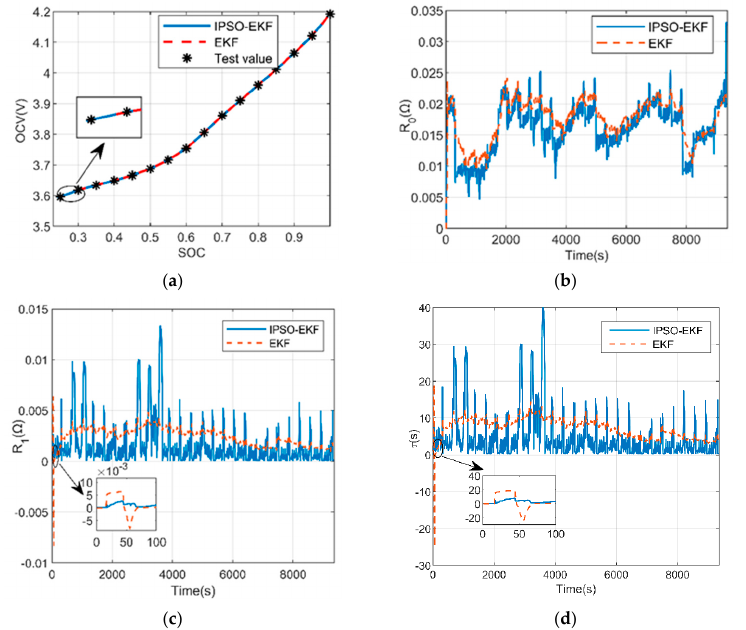
Figure 3. Comparison of the parameter identification values: ( a ) open circuit voltage identification result, ( b ) Ohm resistance identification result, ( c ) polarization resistance identification result, ( d ) and polarization resistance and polarization capacitance product.